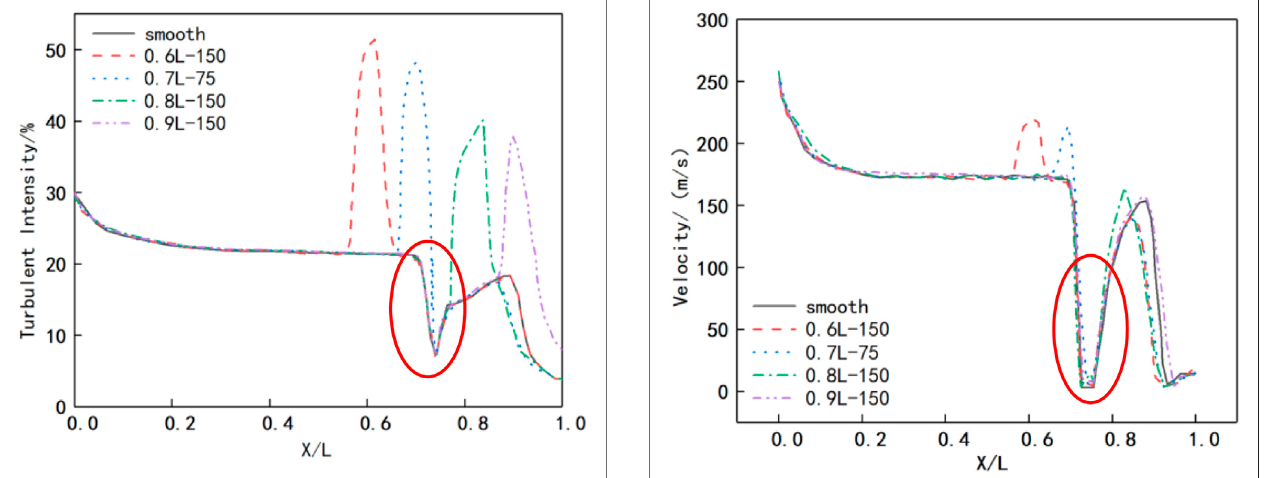
FIGURE 13 | Variation of turbulent intensity on the suction side with roughness height.